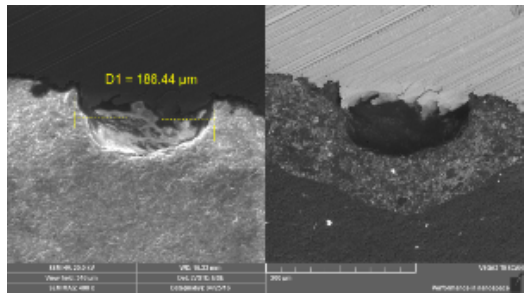
Figure 3. Rupture in the site of the metal-ceramic material contact.